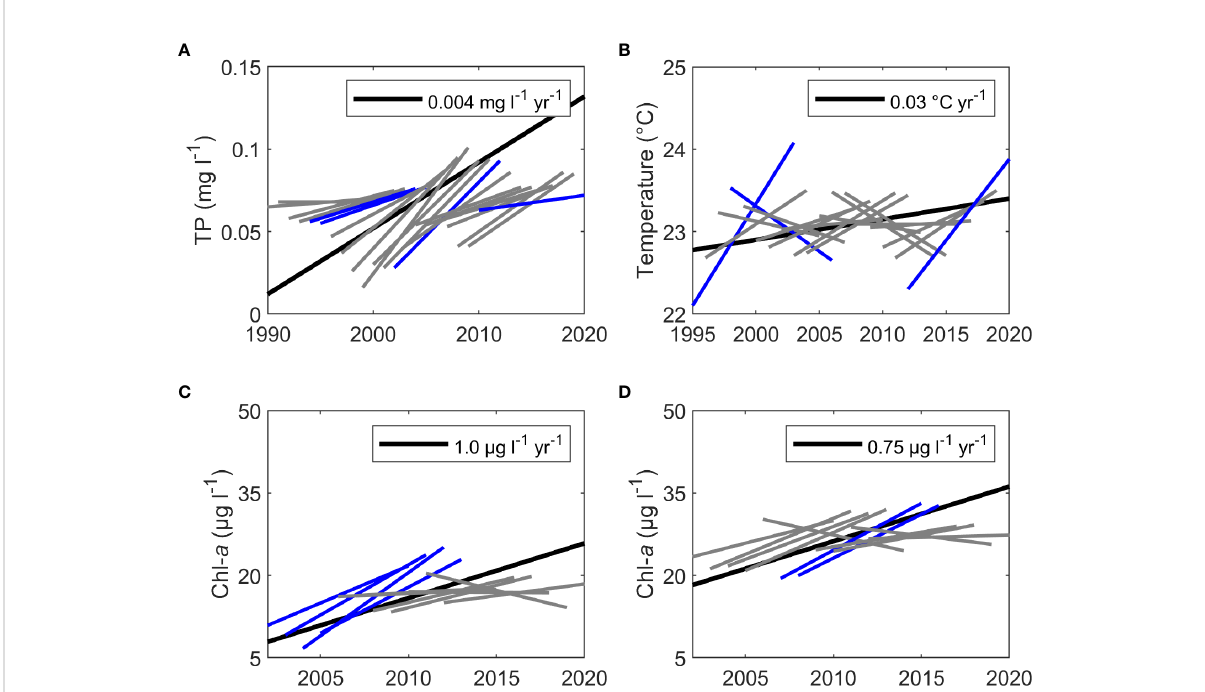
FIGURE 6 Sen slopes (blue and gray) of the rolling Seasonal Kendall test and the signi fi cant ( p < 0.05) Seasonal Kendall monotonic Sen slopes (black) for (A) TP at the gauge, (B) temperature at the SWMP Fish River station, (C) chl- a at the SWMP Fish River station, and (D) chl- a at the SWMP Magnolia River station. Signi fi cant rolling Sen slopes ( p < 0.05) are graphed in blue and non-signi fi cant rolling Sen slopes test are graphed in gray. The Seasonal Kendall Sen slope (black) is graphed to highlight differences in the long-term monotonic slope for the full time series versus the short-term rolling slopes.